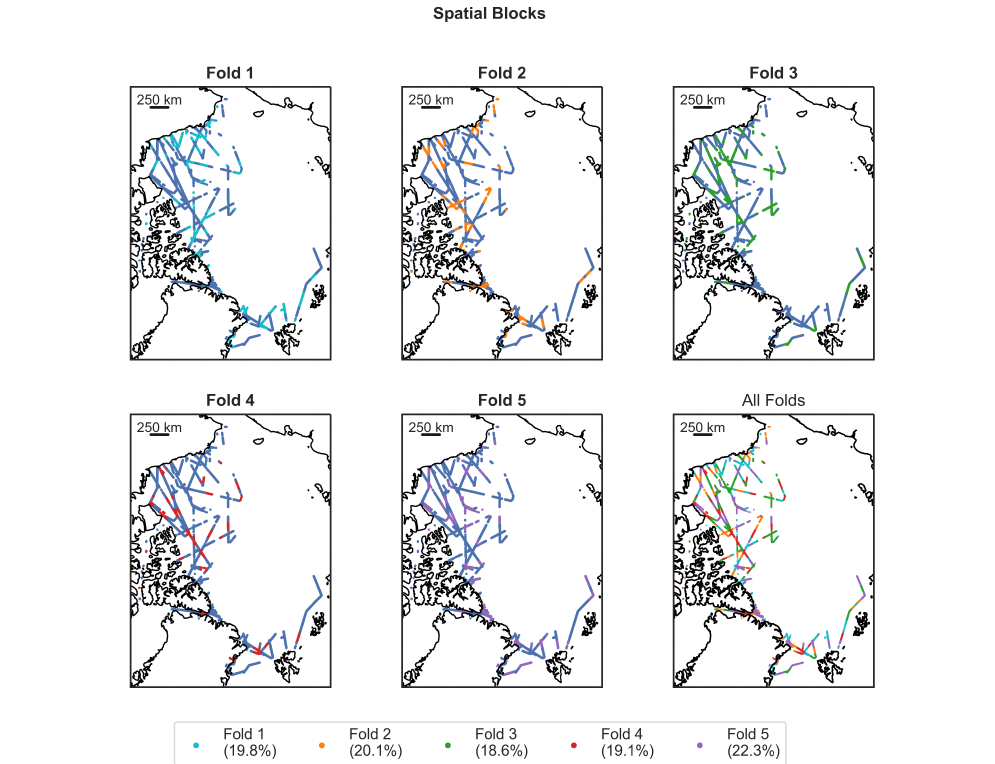
Figure 5. A map demonstrating the permutation of split in each fold for five-fold block k-fold cross validation, using a 100 km block size. WGS 84/NSIDC EASE-Grid 2.0 North. Generated using Cartopy and